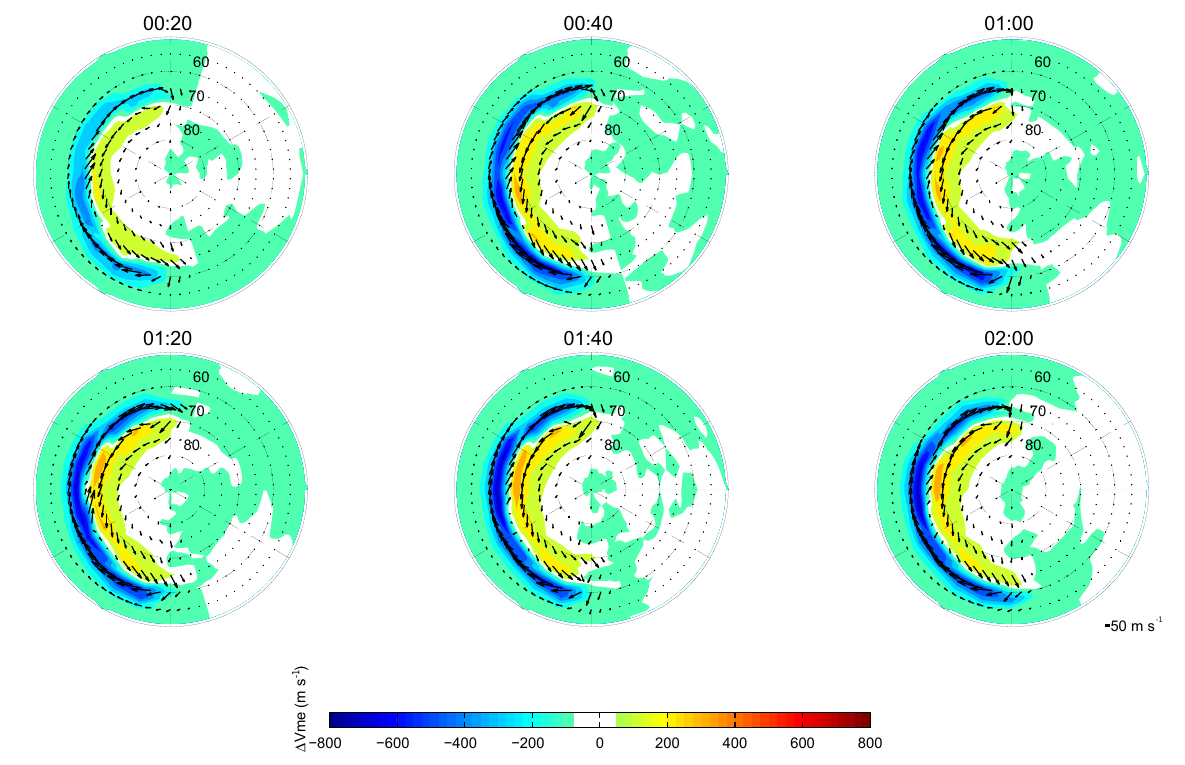
Figure 2. Geomagnetic latitude and magnetic local time variation of the plasma flow in the Northern Hemisphere from 00:20 to 02:00epoch times. Each panel is the difference between the plasma velocity at the panel UT and the plasma velocity 24h earlier. Vectors are shown with black arrows, and the zonal velocity is shown in color. Negative values represent westward plasma